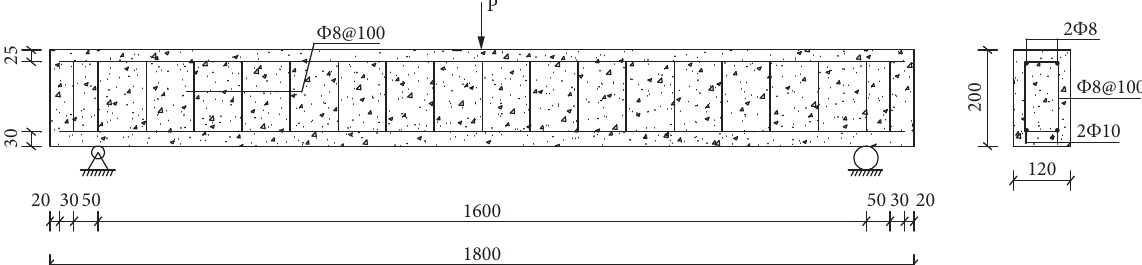
Figure 1: Test beam design and loading scheme.